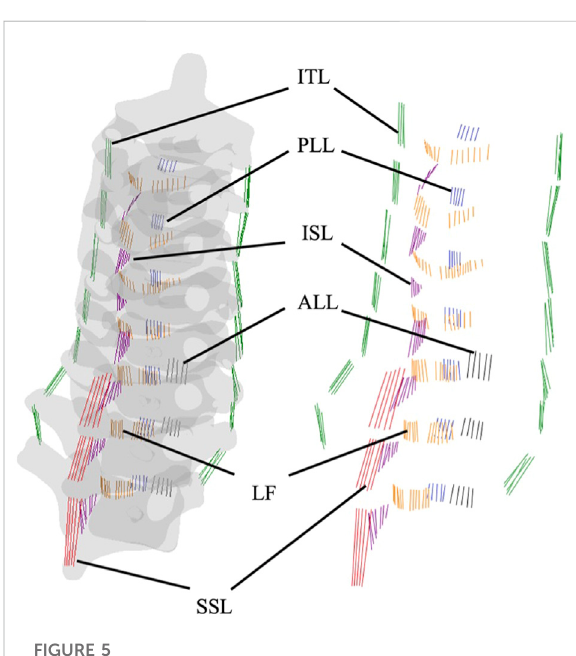
FIGURE 5 Anatomicalschematicsofligamentsandtrusselementsinthe FEA model.